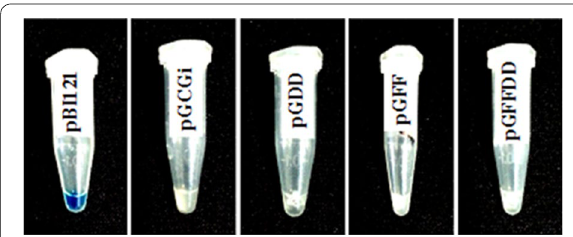
Fig. 3 Lack of prokaryotic expression in pGCGi, pGDD, pGFF, and pGFFDD constructs compared to the prokaryotic expression in pBI121